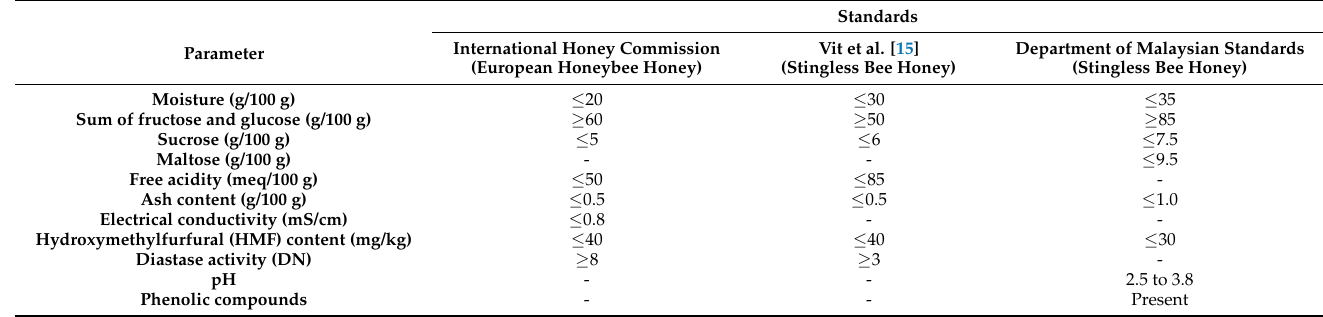
Table 1. Comparison of European honeybee honey standards with stingless bee honey